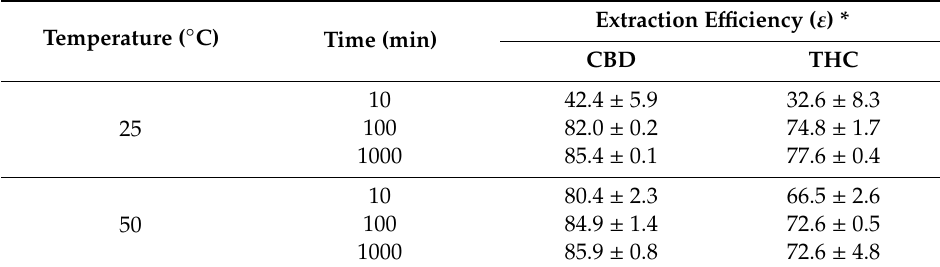
Table 3. Extraction e ffi ciency of the experiments performed in Schott flasks (Section 2.3, Table 1).